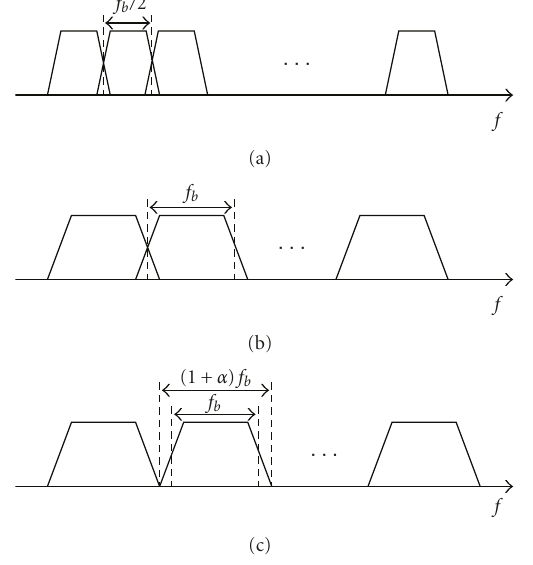
Figure 1: Sample spectra of various FBMC methods. (a) CMT. (b) SMT. (c) FMT.